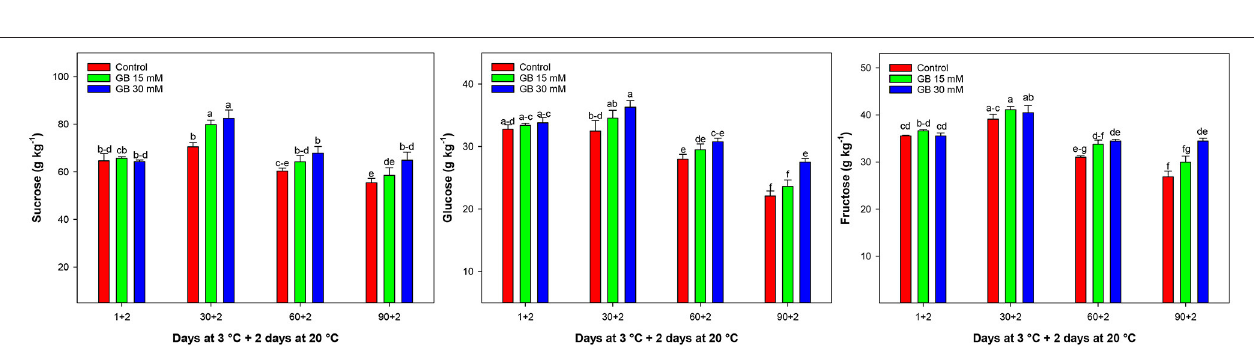
TSS/TA ratio at the last sampling time. In control samples, TSS/TA sharply increased during cold storage. Overall, 30 mM GB was the most effective dose for preserving TSS/TA ratio during cold